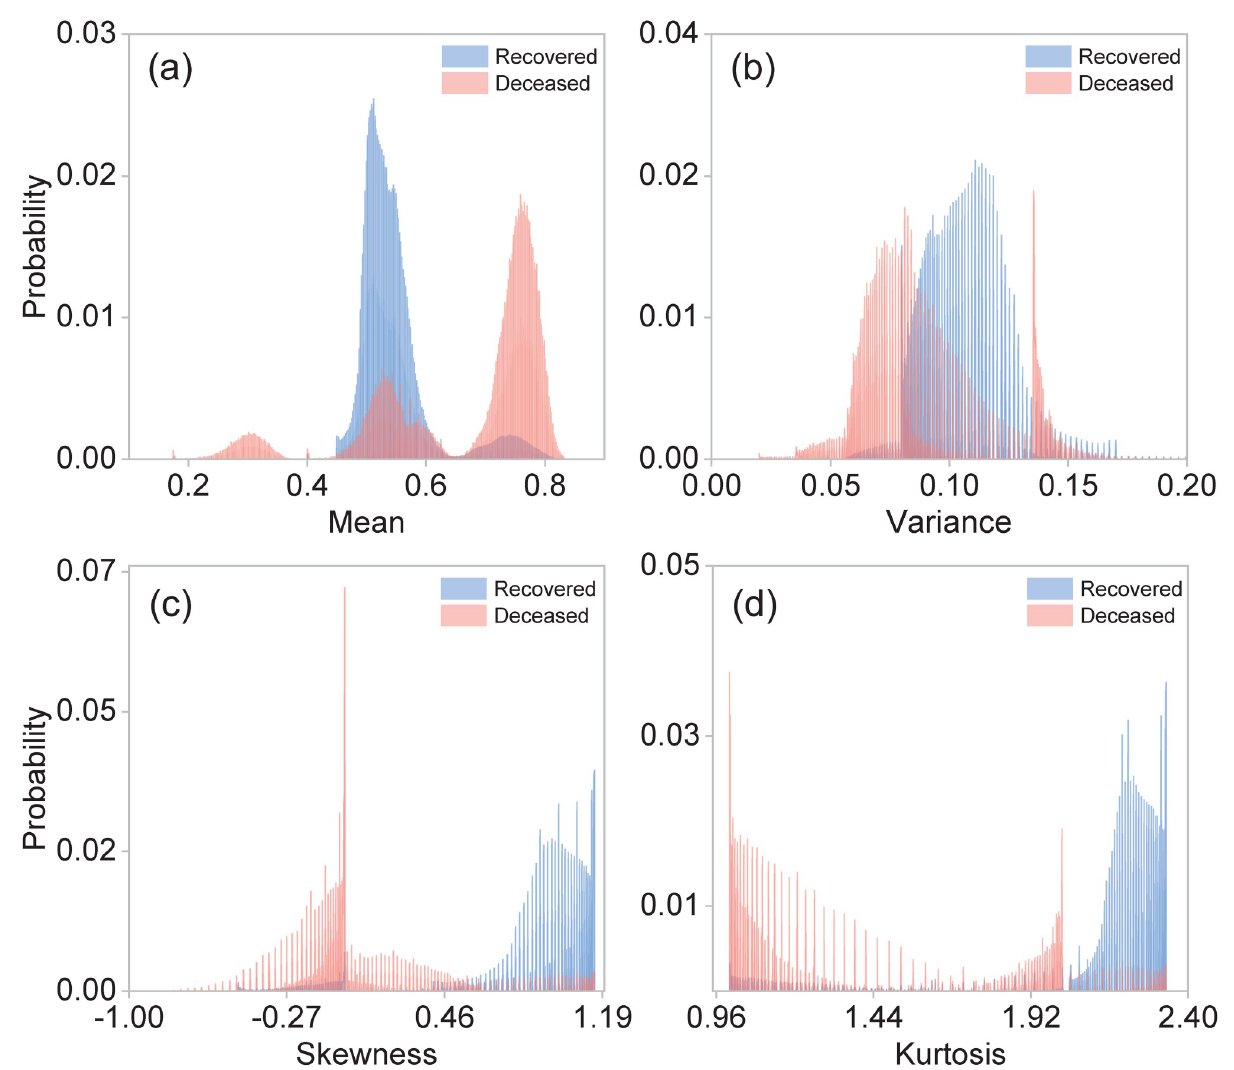
Fig 5. Normalized statistical distributions for different central moments: (a) Mean, (b) Variance, (c) Skewness, and (d) Kurtosis, for class 1 (recovered) shown in blue, and for class 2 (deceased) shown in red. These central moments were computed for a subset of 4 characteristics (age, hospitalization status, intubation and ICU). The distributions were computed from the whole dataset with 4, 700, 464 observations.